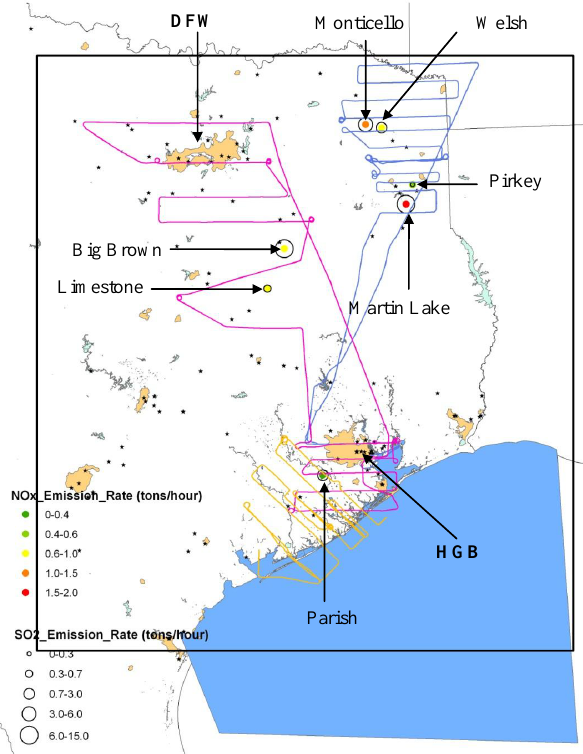
Fig. 1. WP-3 flight tracks (16 September in blue, 19 September in yellow, and 25 September in pink) and power plants in eastern Texas. NO x emission rates are shown by colors and SO 2 emission rates are indicated by size of circles. Rectangular frame shows the 4km modeling domain. Black stars are all other point sources in Texas. The Houston-Galveston-Brazoria (HGB) and Dallas-Forth-Worth (DFW) metropolitan areas are also shown.